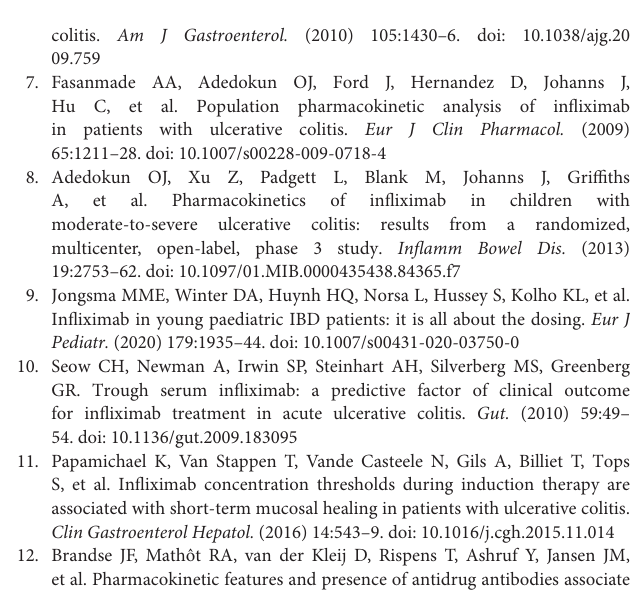
Supplementary Figure 1 | ROC analysis for infliximab serum concentrations at week 1, pre-dose #2, and pre-dose #3 stratifying subjects with and without clinical remission at week 8. Supplementary Figure 2 | Flow of subjects. ∗ Includes one subject who proceeded to colectomy. Supplementary Table 1 | Test characteristics of pre-dose #2 and pre-dose #3 infliximab concentration cut-offs with week 8 clinical remission. IFX, infliximab; AUROC, area under receiver operator curve.